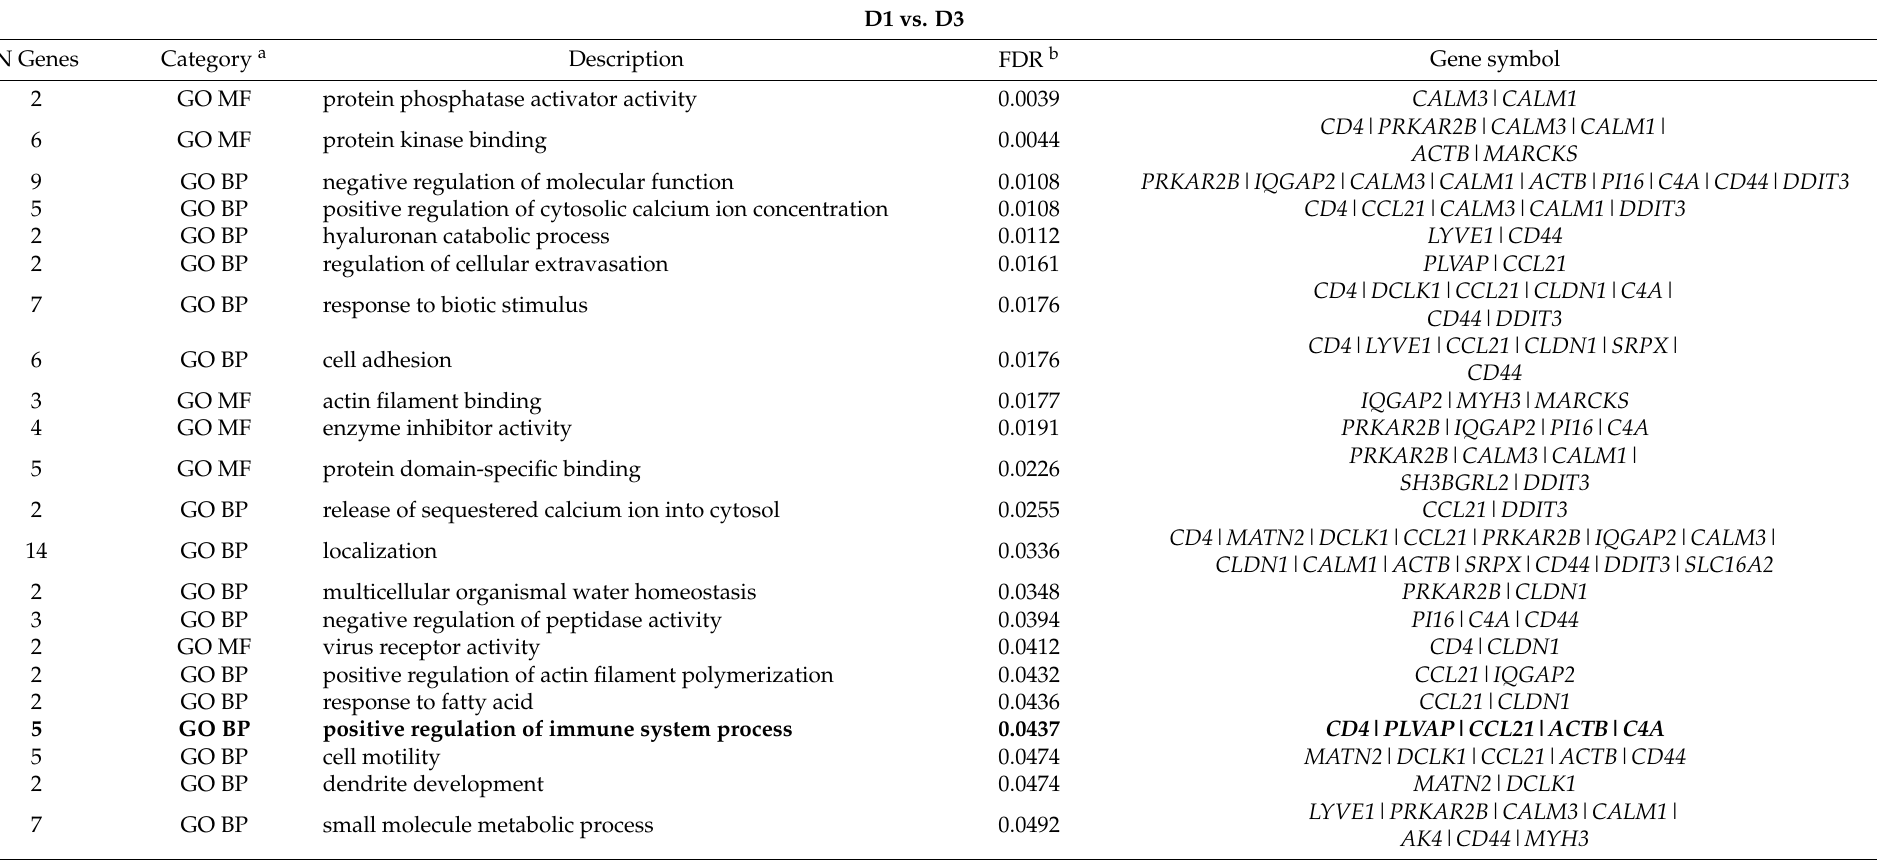
Table 3. Functions and pathways generated by functional analysis with Cytoscape were used for each comparison (D1 vs. D3 and D1 vs. D4) of the respective differentially expressed genes. For each category, there are numbers and symbols of genes of the category of belonging (categories of Gene Ontology (GO) or Reactome or KEGG Pathways); description; and False Discovery Rate (FDR). The pathways marked in bold are those of interest to the